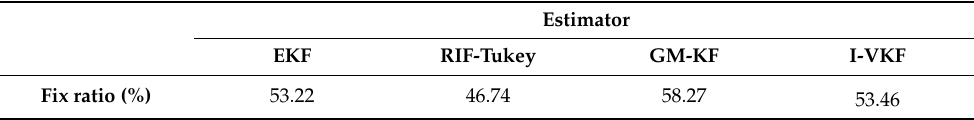
Figure 9. ( Left ) Positioning errors; ( right ) cumulative distribution function (CDF) for the different methods. Table 3. Percentage of fixed solutions